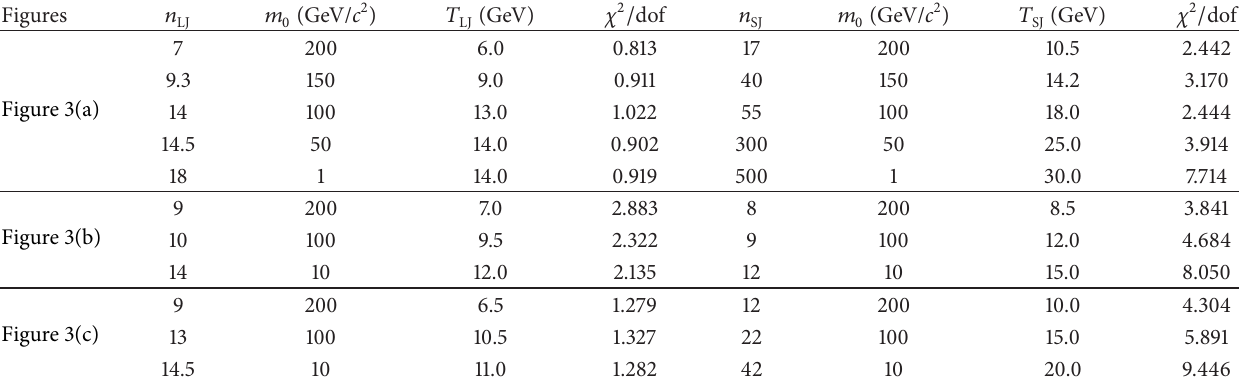
Table 3: Parameter values for different curves of the L´evy distributions in Figure 3. The values of 𝜒 2 / dof and extracted temperatures are given. The little marks LJ and SJ represent leading and subleading jets, respectively. The relative errors for the parameters are less than 10%.